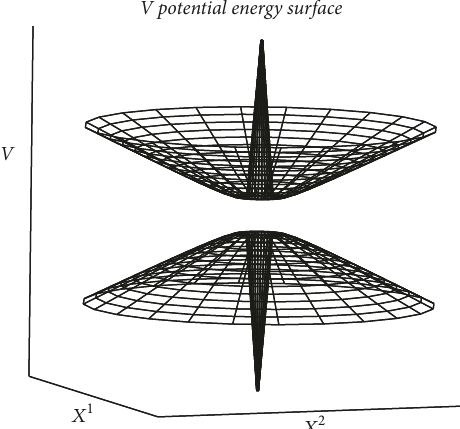
Figure 3: Schematic images of the potential energy 𝑉 1 in a relation to 𝑌 and (𝑋 1 , 𝑋 2 , ..) are